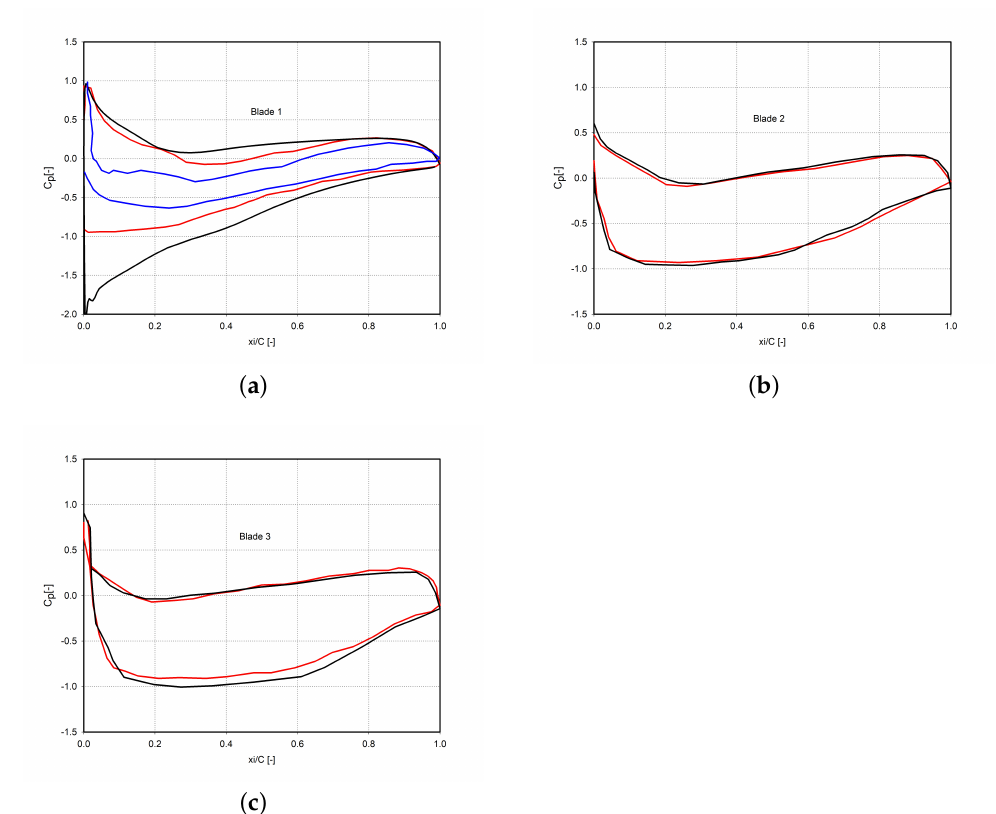
Figure 18. ( a – c ) Calculated static pressure coefficient at r / R = 0.8 for the balanced (red lines), positive pitch imbalance (black lines) and negative pitch imbalance (blue line)